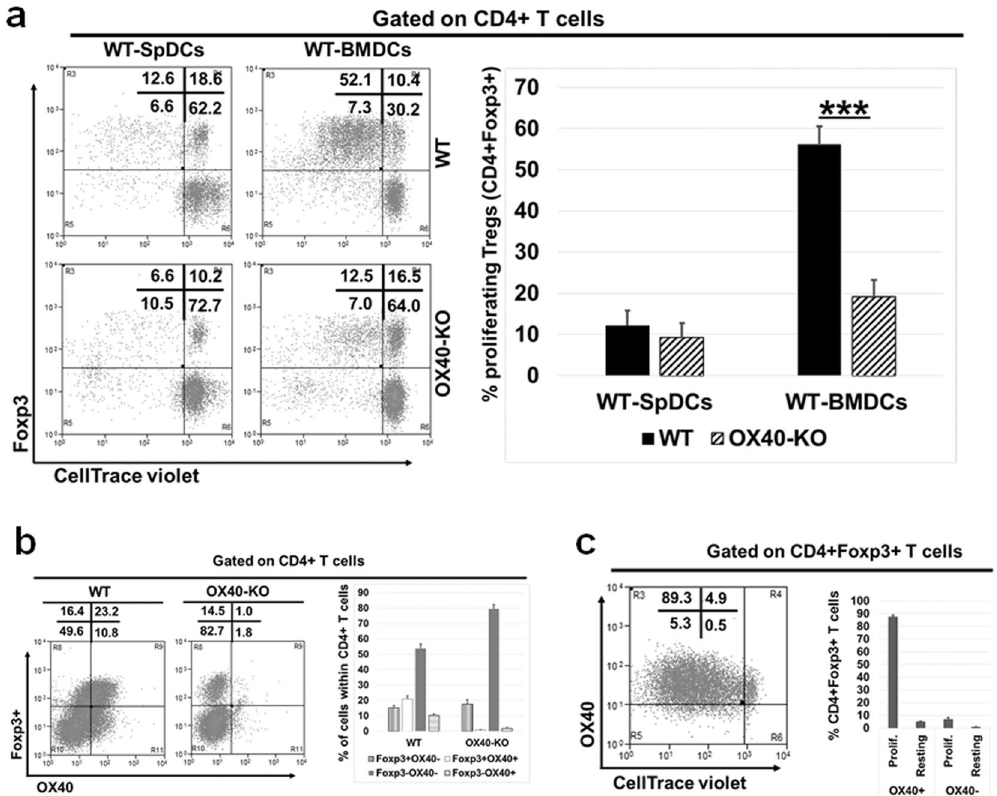
Figure 1. OX40-KO Tregs show impaired proliferation compared to WT Tregs. WT and OX40 − / − splenic total CD4 + T-cells, isolated and labelled with CellTrace violet, were co-cultured with WT-BMDCs. After five days, cells were harvested and analysed by flow cytometry. ( a ) Dot plot (left) and summarizing bar graphs (right) show Treg proliferation in OX40-KO cells compared to WT. ( b ) Dot plot (left) and summarizing bar graphs (right) showing the expression of Foxp3 and OX40 in WT and OX40-KO CD4 + T-cells. ( c ) Dot plot (left) and summarizing bar graphs (right) showing the expression of OX40 among the proliferating and resting Tregs (CD4 + Foxp3 + ). Values show average ± SD, * P < 0.05, ** p < 0.005, and *** p <